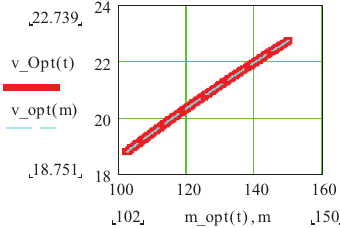
Figure 5. Phase trajectory of the optimal speed over optimal mass through the phase variable of